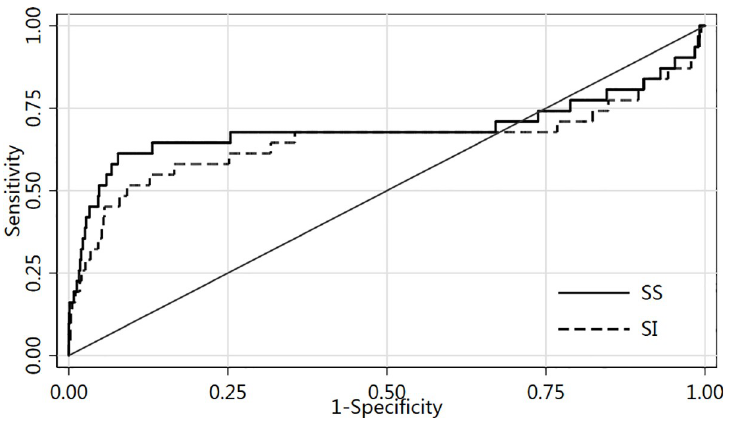
Fig 1. ROC curves of the SS and